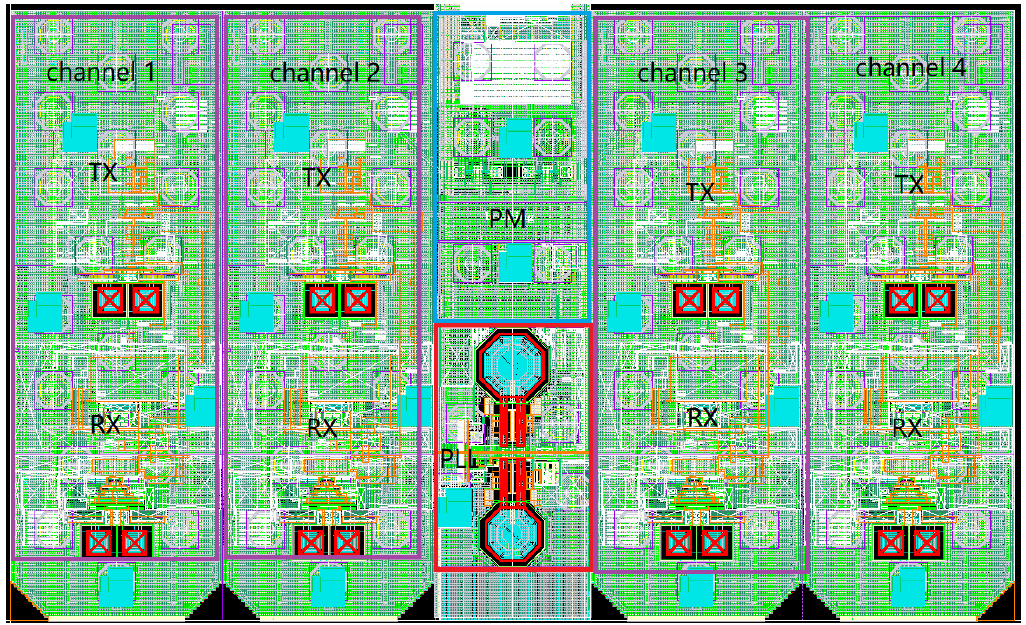
Figure 6. Layout of SerDes and PLL. RX: Receiver; PM: power management.